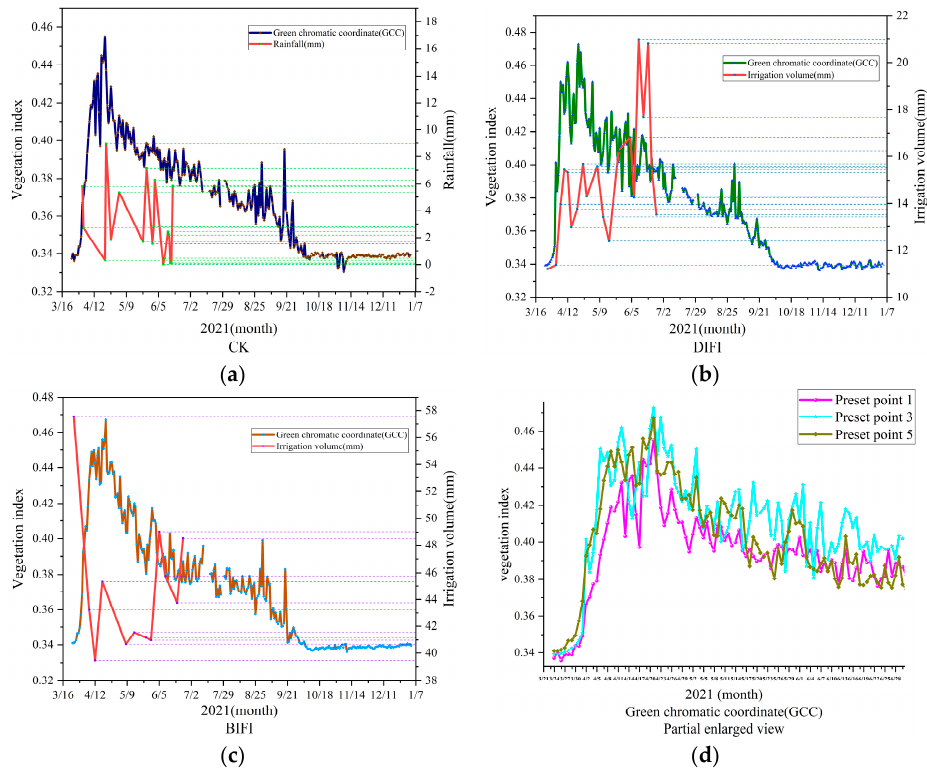
Figure 9. Changes in GCC vegetation index under different irrigation methods: ( a ) Relationship between CK and GCC vegetation index data, ( b ) Relationship between DIFI and GCC vegetation index data, ( c ) Relationship between BIFI and GCC vegetation index data, ( d ) GCC- local enlarged view during growth.